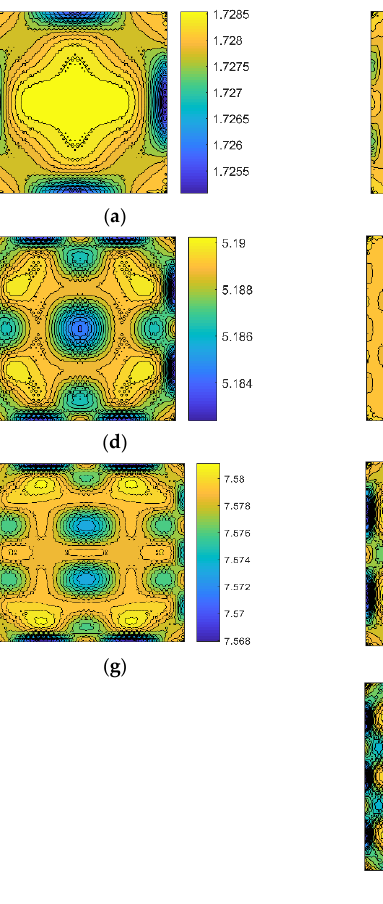
Figure 4. The fingerprints of the resonant frequencies pairing with the location of atomic vacancy defects in graphene (( a – j ) represent the 1st to the 10th resonant vibration modes, respectively; the unit for the color bars is Thz).